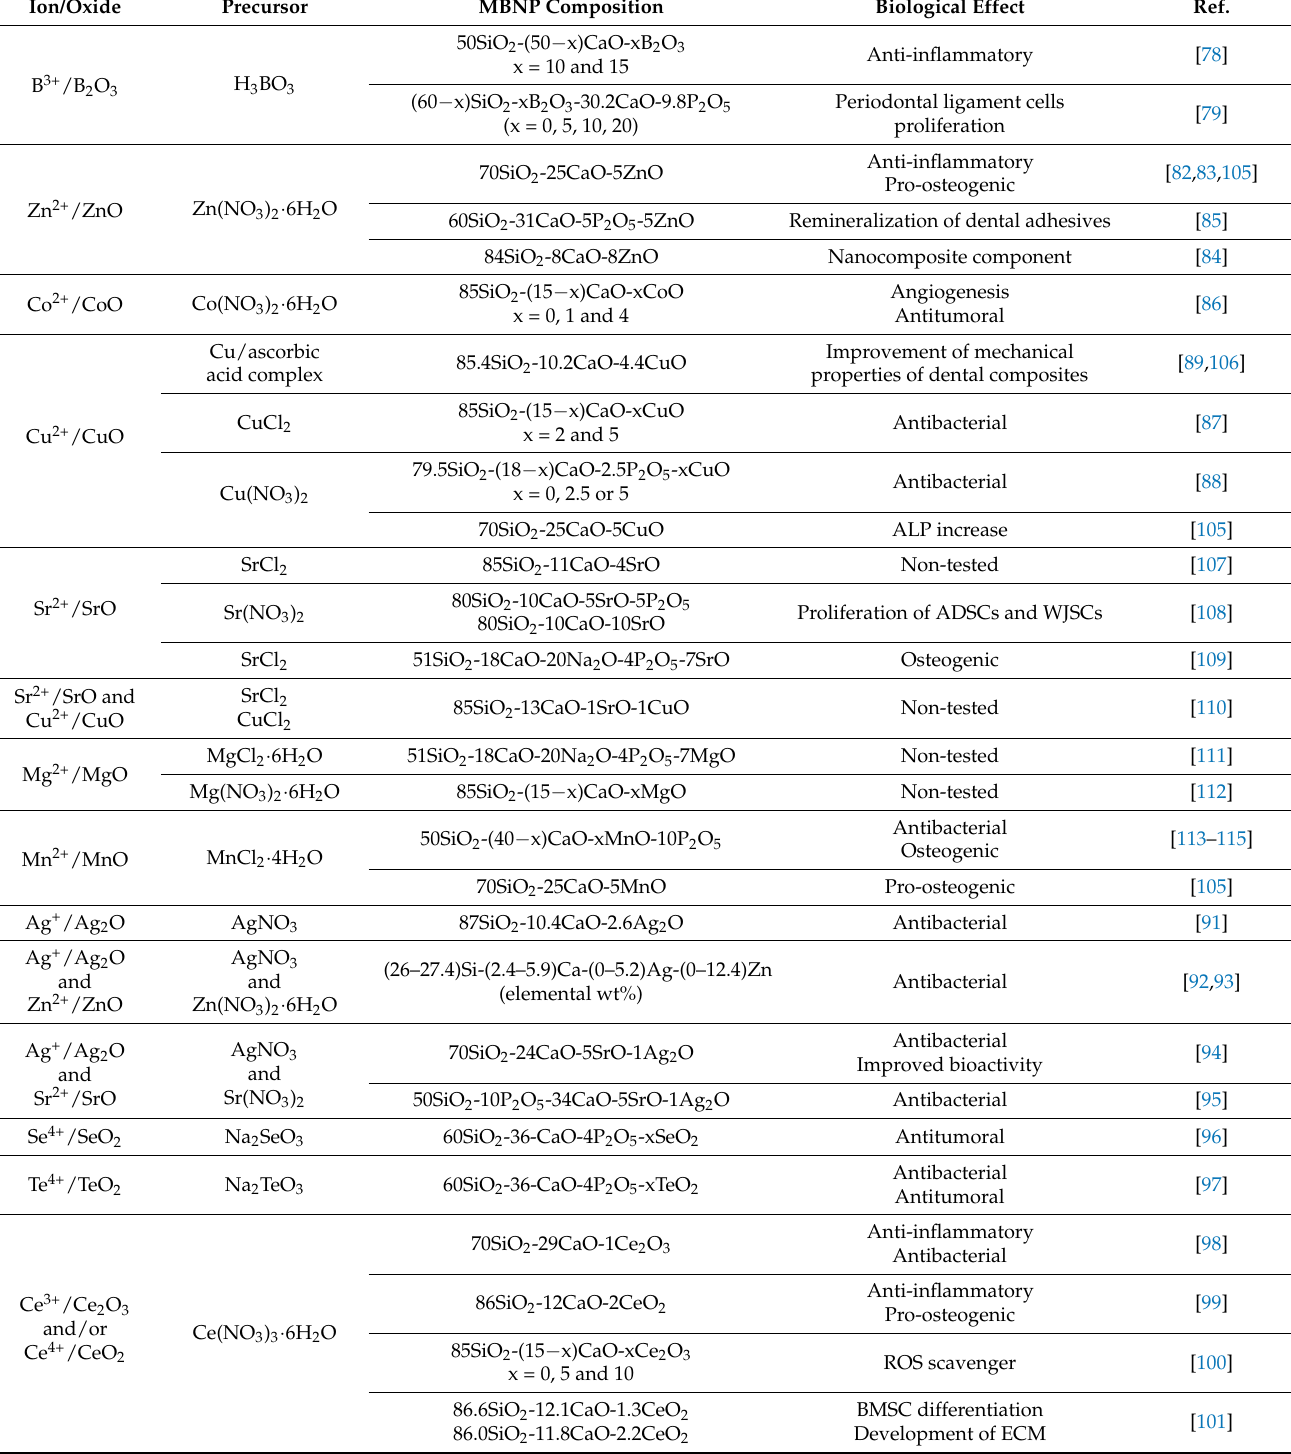
Table 3. Ion-doped mesoporous bioactive nanoparticles: compositions and therapeutic effects. Ion/Oxide